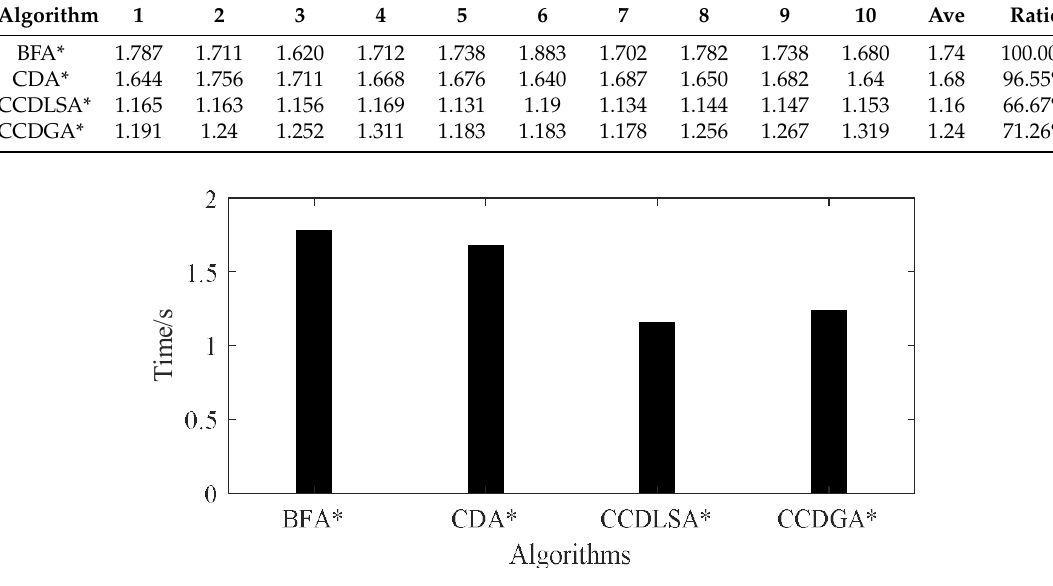
Figure 16. Average Diagnosis Time for BFA*, CDA*, CCDLSA* and CCDGA*.